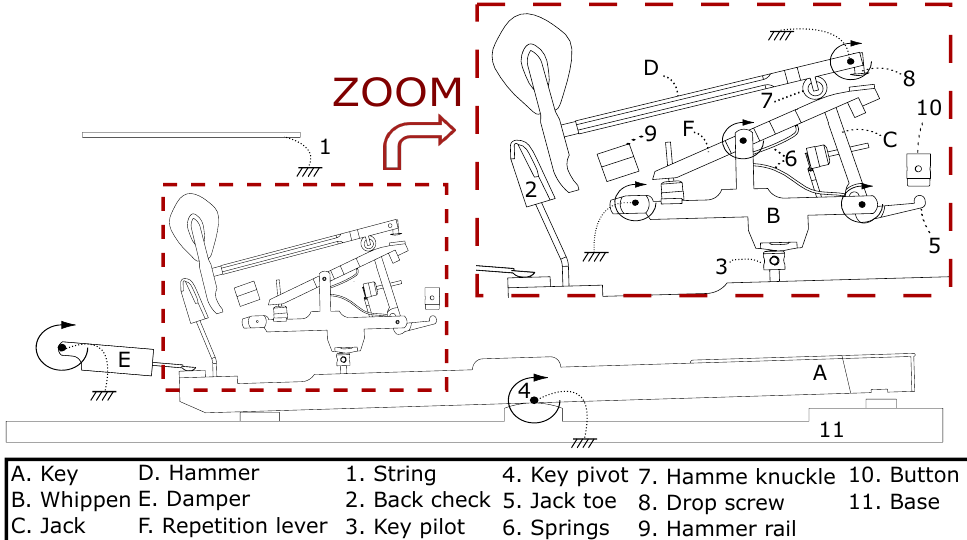
Figure 9. Main components of the grand piano action for the MBS model: mobile bodies (resp. other elements) are indicated by letters (resp. numbers). Circular arrows represent the DOFs (adapted from